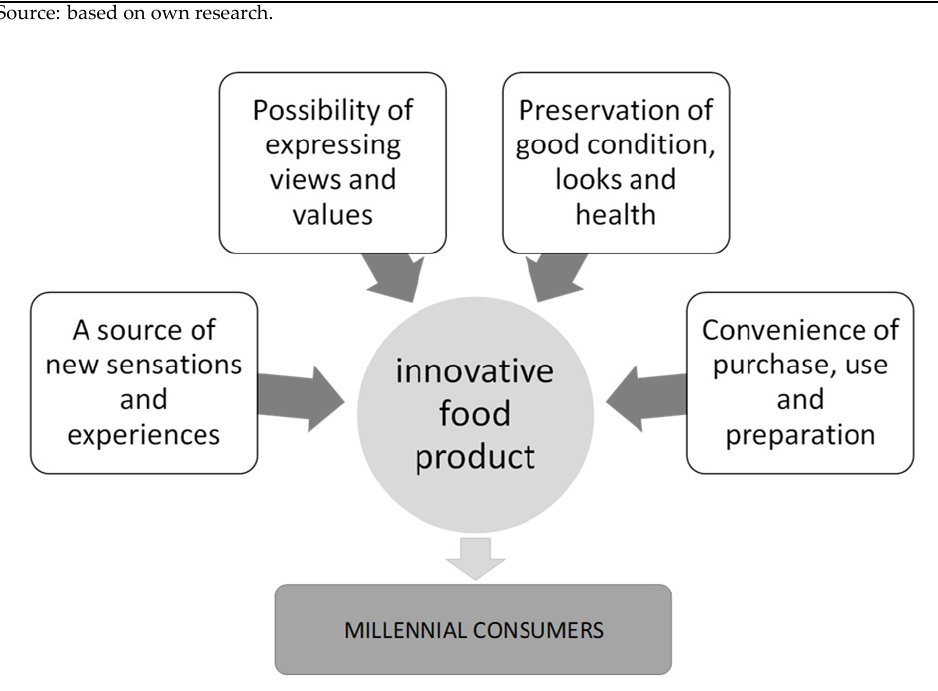
Figure 3. Main factors expressing the value of food products for the Polish consumer, determined based on exploratory factor analysis (the values of individual factors were 2.48, 1.67, 2.07, and 2.43, respectively). Identified factors explain approximately 83% of the total variance. Source: based on own research.